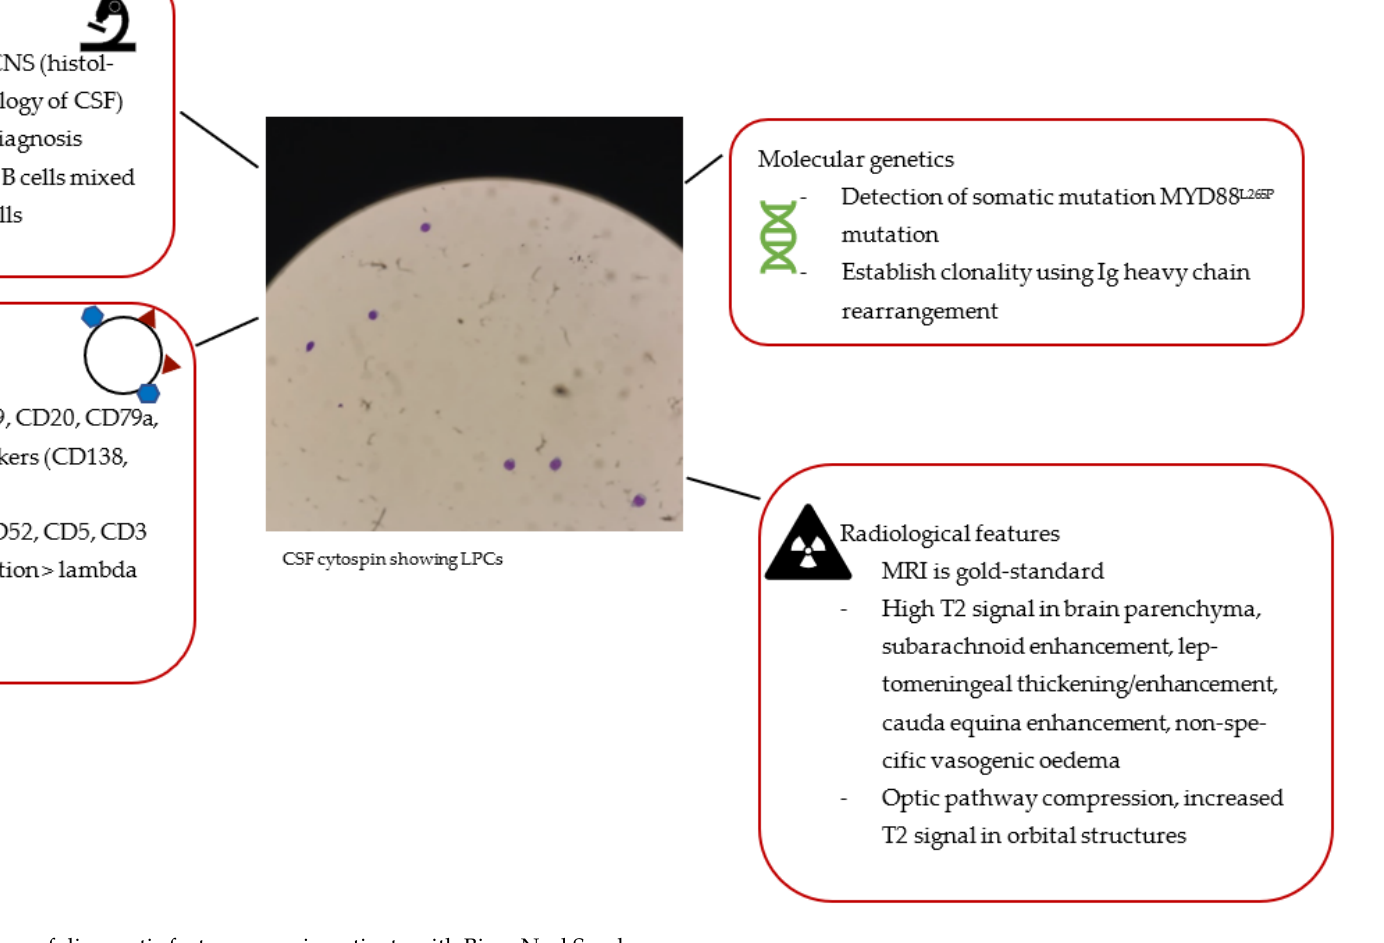
Figure 1. Summary of diagnostic features seen in patients with Bing – Neel Syndrome.